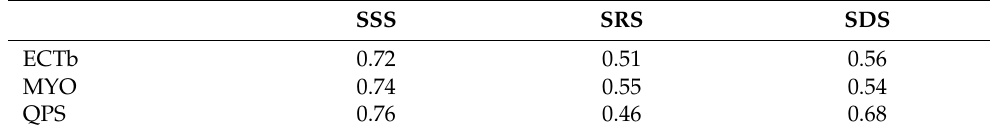
Table 4. Spearman correlation coefficients of expert estimations of SSS, SRS and SDS and the corre- spondent values derived from ECTb, MYO, and QPS software packages. SSS SRS SDS ECTb 0.72 0.51 0.56 MYO 0.74 0.55 0.54 QPS 0.76 0.46 0.68